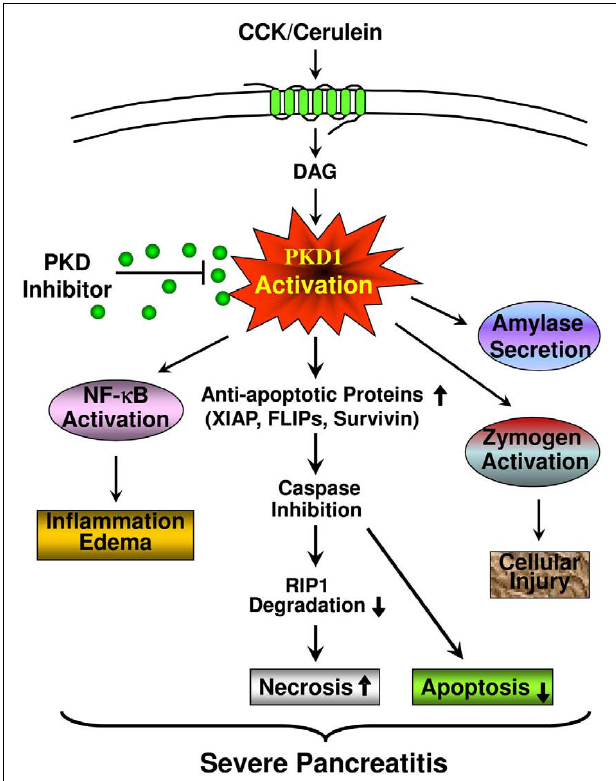
FIGURE 10 |A scheme summarizing the role of PKD/PKD1 in multiple pathological processes of pancreatitis and the mechanisms of PKD activation mediating cell death in pancreatitis. CCK/cerulein-induced PKD activation increases the levels of anti-apoptotic proteins (XIAP, c-FLIPs, and survivin).The increased anti-apoptotic proteins suppress caspase activation and apoptosis. Caspases inhibition also results in decreased cleavage/inactivation of RIP1, thus, leading to increased necrosis and the severity of pancreatitis.This cell necrotic death response is blocked when PKD is inhibited. PKD inhibition promotes apoptosis and decreases necrosis.Thus, PKD inhibition will switch cell death away from necrosis. As we previously reported, PKD/PKD1 also mediates other pathological processes of pancreatitis, including NF- κ B activation and inflammatory response, zymogen activation, and amylase secretion. All these effects indicate that PKD/PKD1 may represent a potential therapeutic target